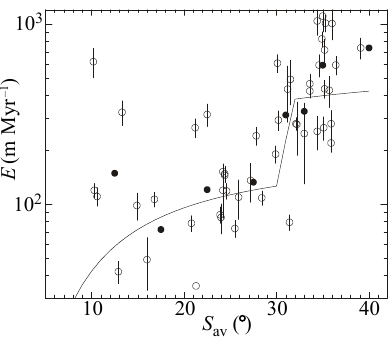
Figure 8. Plot of the catchment-averaged erosion rates of DiBi- ase et al. (2010) (unfilled circles) versus catchment-averaged S av . Filled circles represent log-transformed averages of data within the following bins: 10–15, 15–20, 20–25, 25–30, 30–32, 32–34, and 34–36 ◦ . The curve plots the model prediction, i.e., Eq. (8) with P r values predicted by Eq. (5) and h values predicted by Eq.